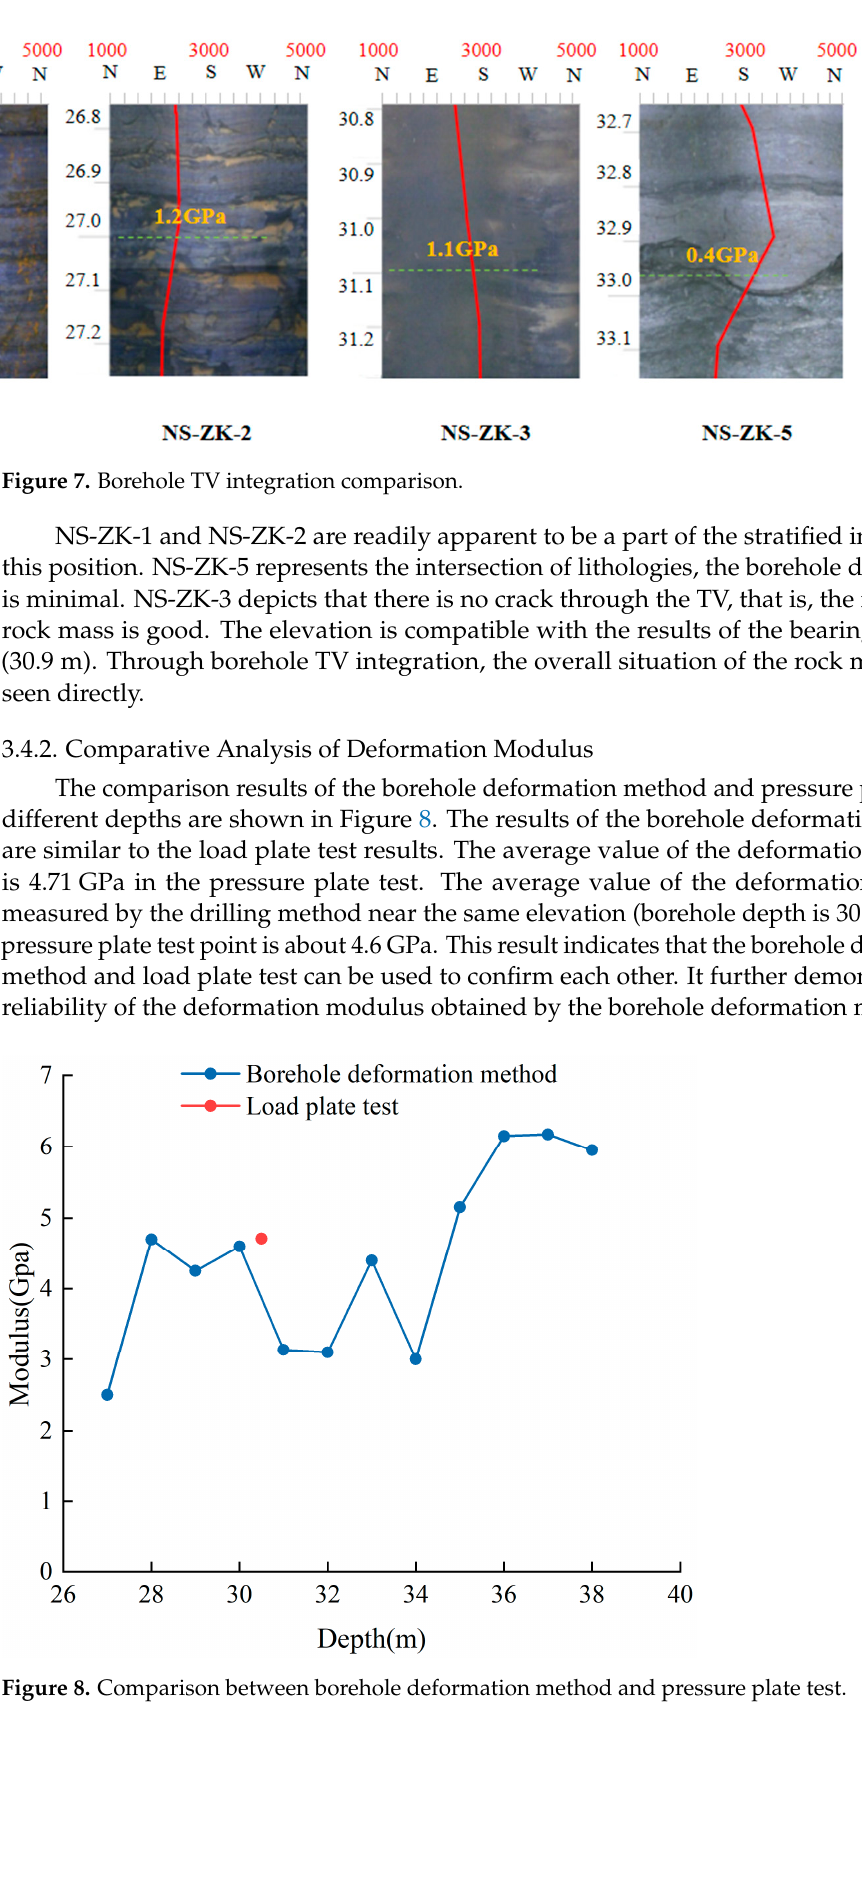
Figure 8. Comparison between borehole deformation method and pressure plate test.